Question: According to this chart, does the measure grow or shrink?
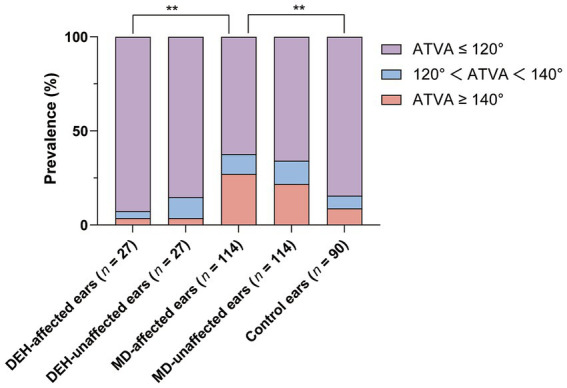
Answer: decreasing